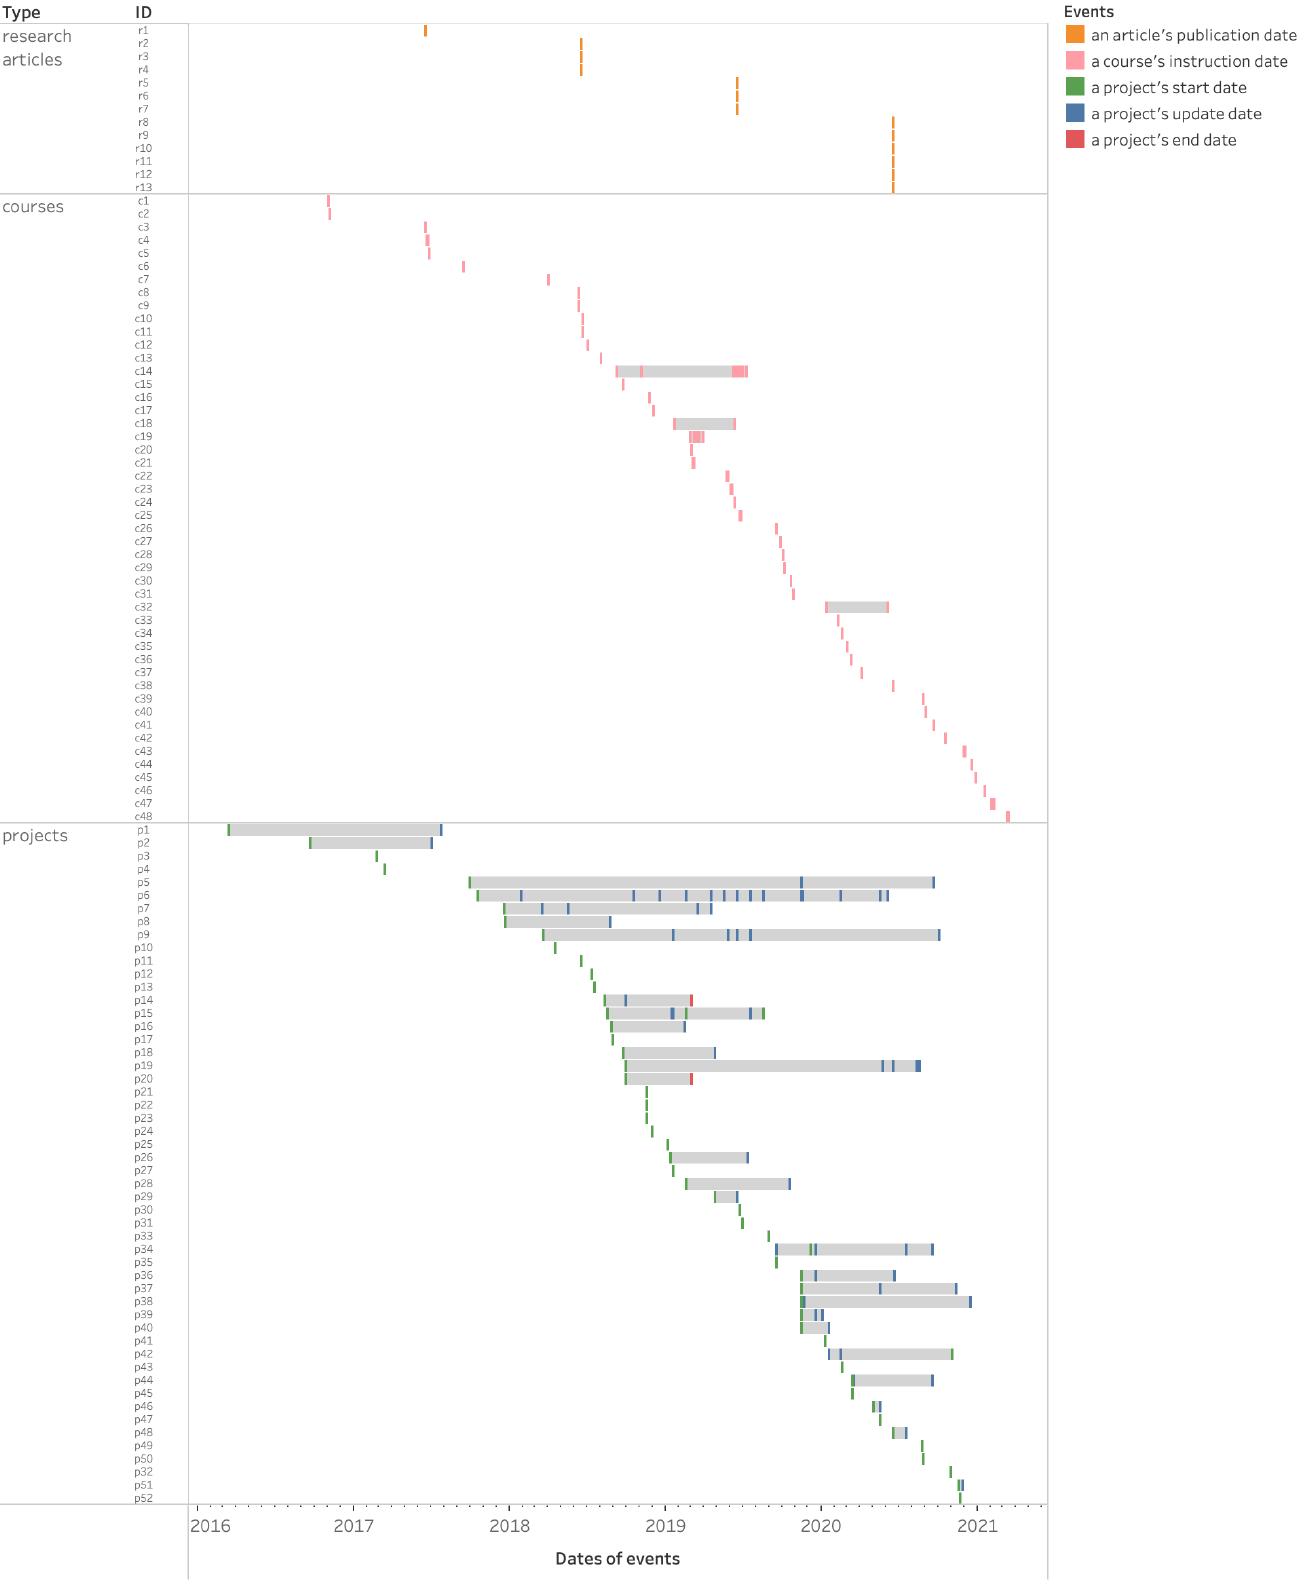
Figure 17. A visualization showing timelines of research articles, courses, and projects about blockchain in Thailand. Some courses and projects were excluded due to imprecise